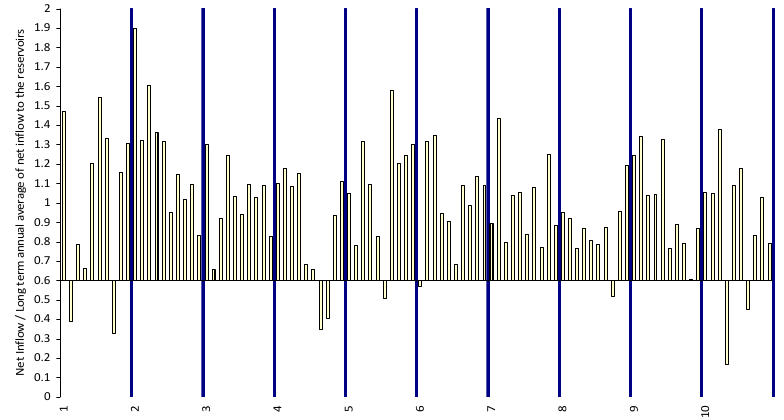
Figure 3. Comparing average with long term annual average values of net inflow for the 10 synthetic decades.